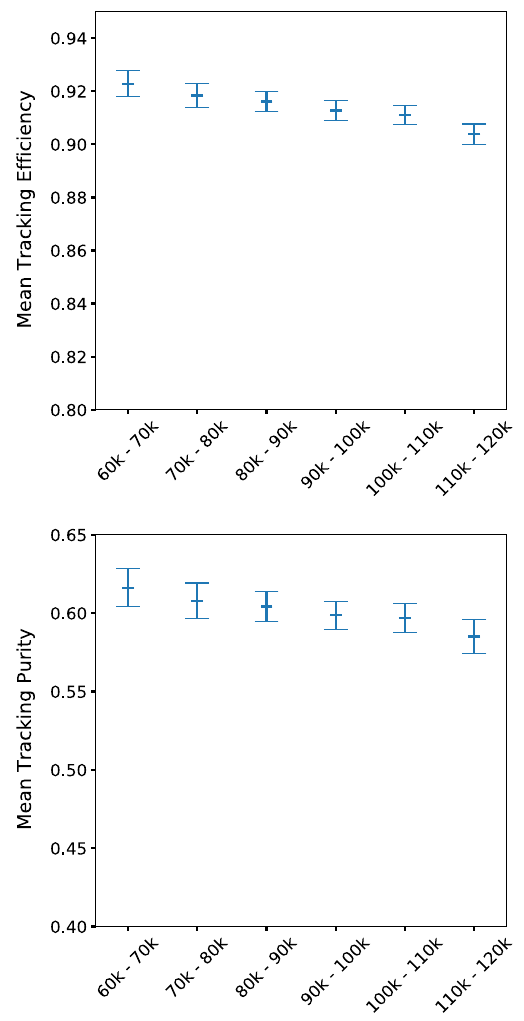
Fig. 6 Mean and standard deviation of the technical efficiency (top) and purity (bottom) as a function of the total number of spacepoints in an event Table 1 Technical efficiency and purity for different noise fractions ( N noise